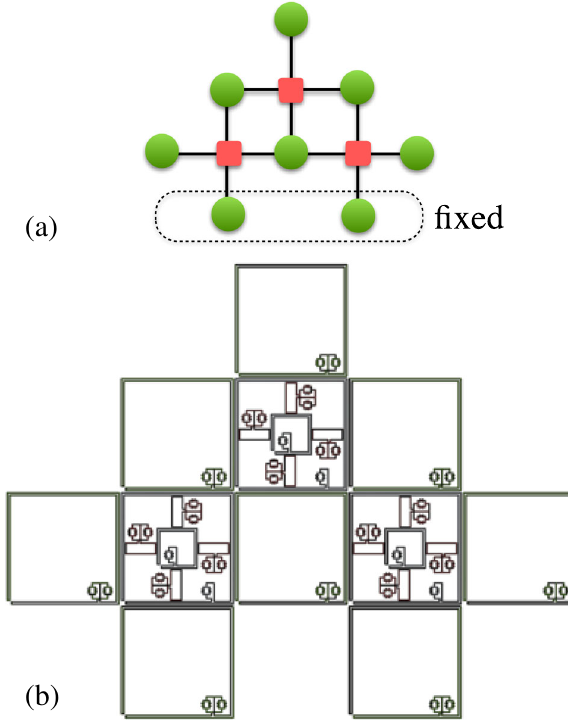
Fig. 4 a Schematically illustration of the embedding technique proposed in ref. 25 Shown is an embedding for M = 3 logical qubits whose interactions are mapped onto K = 6 physical qubits ( green circles ). Besides the six physical qubits encoding the interactions, there are an additional two physical qubits which enforce the boundary condition. The physical qubits are coupled using four- body interactions as illustrated by the plaquette ( red squares ). b A physical circuit implementation of the above embedding using our circuit design of a four-body term as presented in the previous section. The four qubits surrounding the four-body circuit are extended to couple to neighboring four-body circuits. This presents a concrete circuit design for a scalable quantum annealing architecture using superconducting